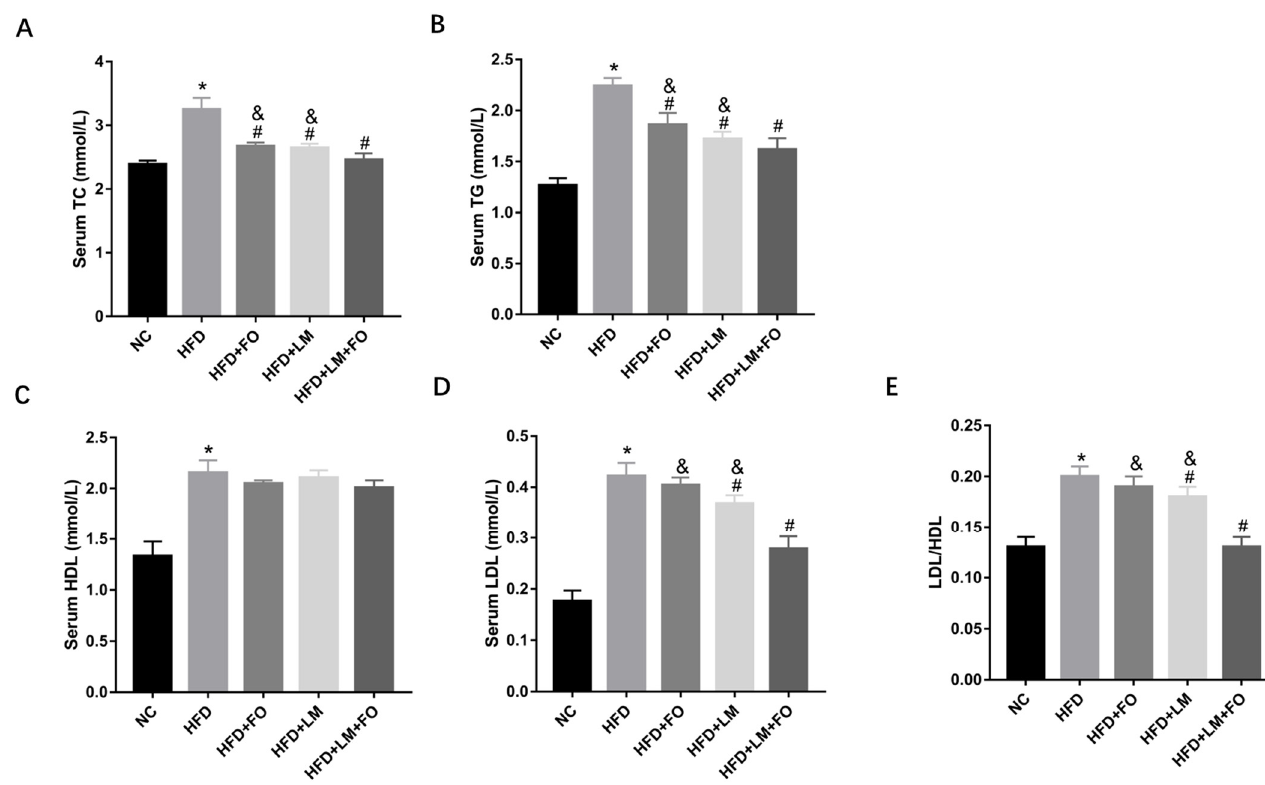
Figure 2. Effects of FO and LM on serum lipid accumulation in HFD mice. Serum lipid profile in- volved ( A ) TC, ( B ) TG, ( C ) HDL, and ( D ) LDL, and ( E ) the ratio of LDL/HDL was detected by kits. Data are presented as means ± SD ( n = 3). * p < 0.05 vs. NC; # p < 0.05 vs. HFD; & p < 0.05 vs. LM + FO.